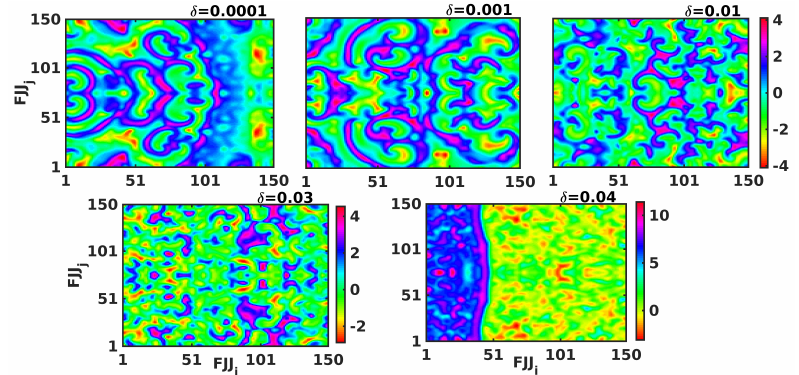
Figure 10. The energy of a network by fixing the variance of the BM noise as different values, δ = 0.0001, δ = 0.01, δ = 0.1, δ = 1, δ = 5, and δ = 10. Other parameter values are same as in Figure